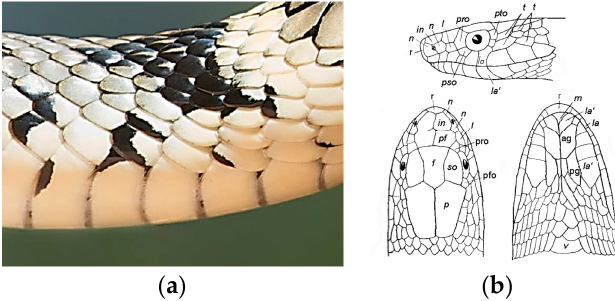
Figure 16. ( a ) Scales on a snake show smaller scale sizes on the top/dorsal side and larger bands of scales on the bottom/ventral side, minimizing frictional losses; ( b ) the head region shows a distribution of smaller scale sizes, probably adapted for flexibility to enable the jaw to open wide.